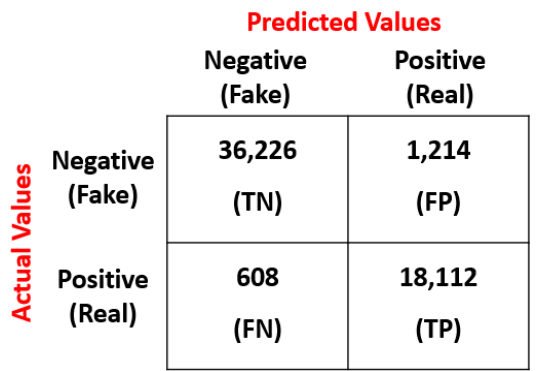
Figure 11. The result of confusion matrix for protocol 4 (TN: True Negative, TP: True Positive, FN: False Negative, FP: False Positive).